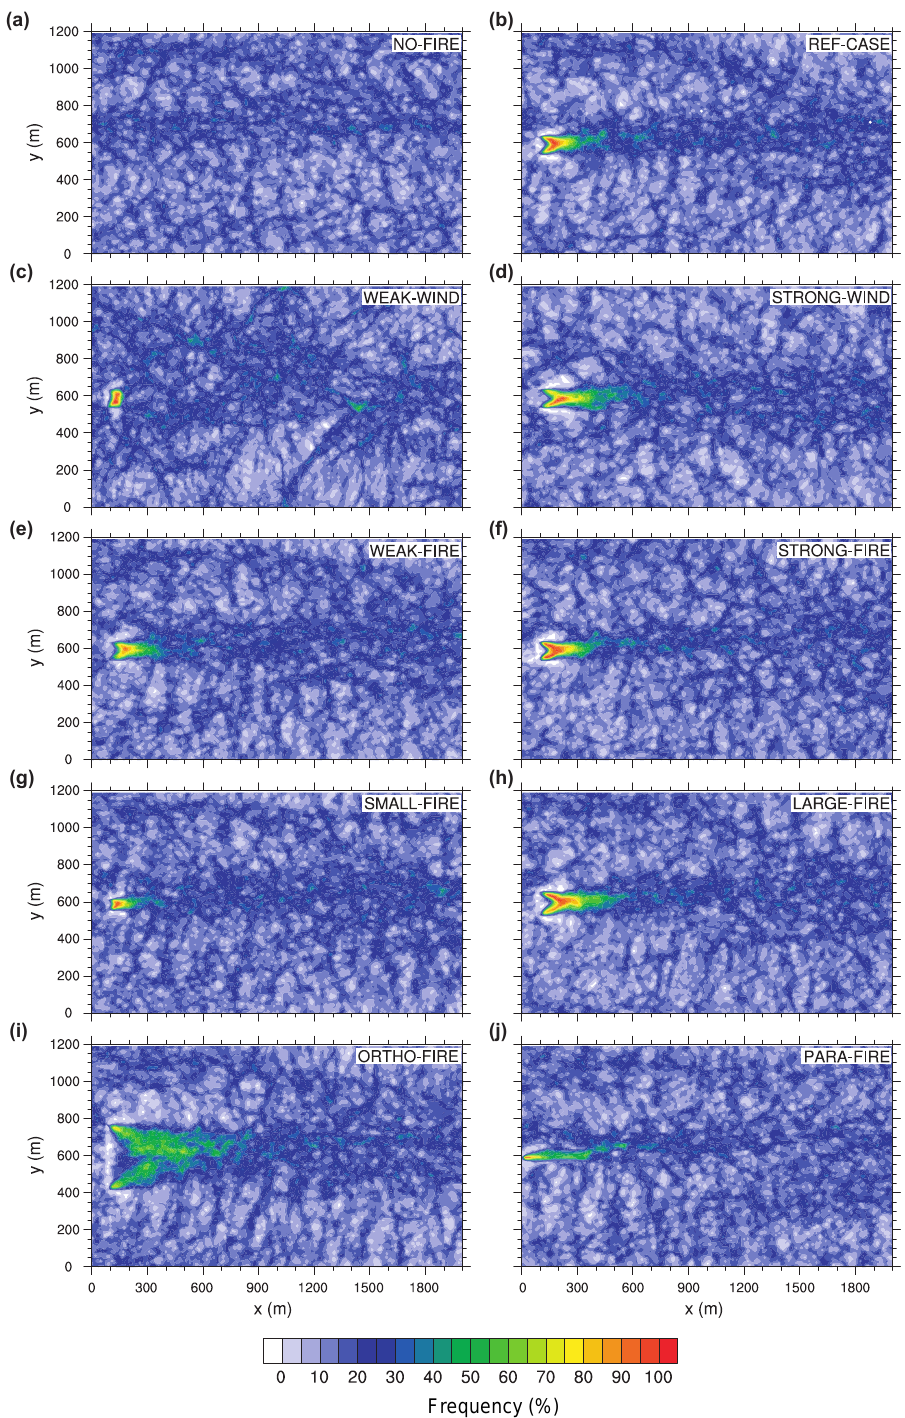
Figure 10. Spatial distribution of areas where the vertical wind velocity w 4 in the lowest model level is greater than 0.27ms − 1 . Shown is the frequency of occurrence of such updraft velocities per grid